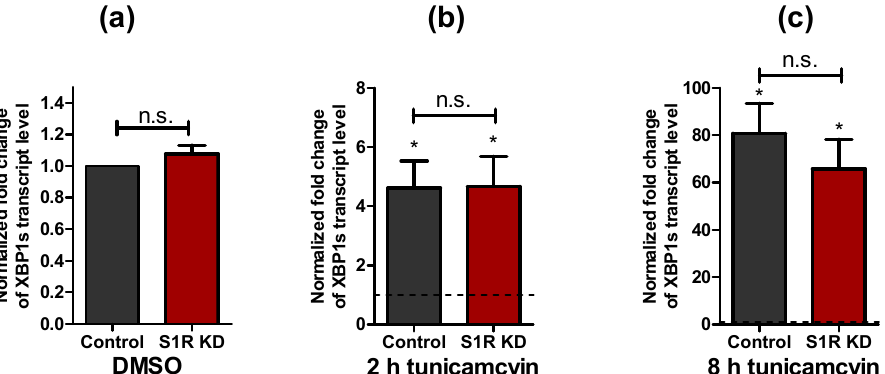
Figure 1. Impact of tunicamycin treatment on XBP1 splicing levels. Bar graphs represent mean ± SEM of spliced XBP1 transcript levels in control and S1R KD SH-SY5Y neuroblastoma cells under control conditions ( a ) or after tunicamycin treatment for 2 h ( b ) and 8 h ( c ). Dashed lines represent the transcript level of spliced XBP1 in the respective DMSO treated cells. Paired t-test, n = 3, * p < 0.05 against corresponding DMSO treated cells; unpaired t-test between control and S1R KD, n = 3, n.s.—not significant.